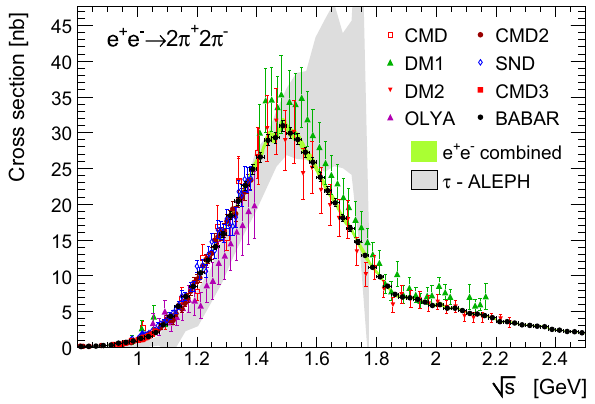
Fig. 5 Bare cross sections for e + e − → π + π − 2 π 0 ( left ) and e + e − → 2 π + 2 π − ( right ). The error bars of the data points include statistical and systematic uncertainties added in quadrature. The green bands show